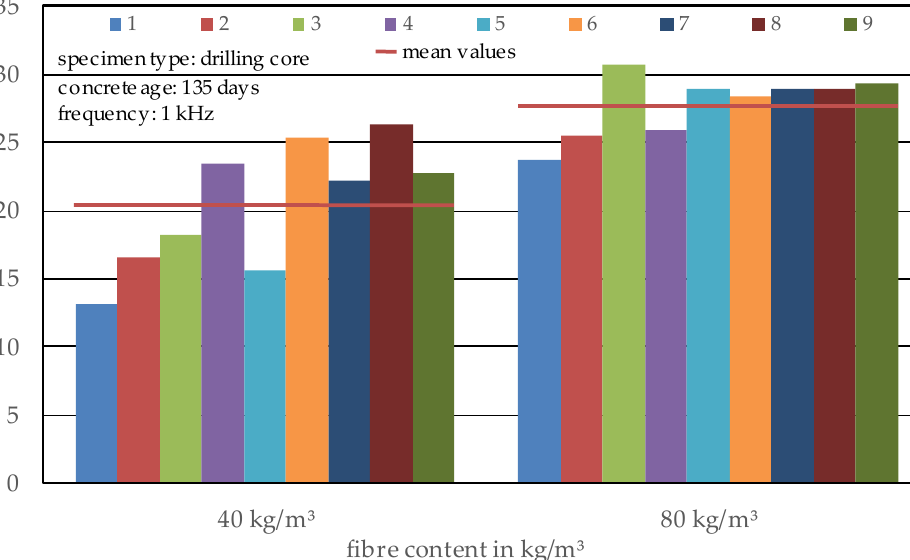
Figure 13. Coefficient of variation of the calculated electrical resistivity of drilling cores depending on the fibre content.